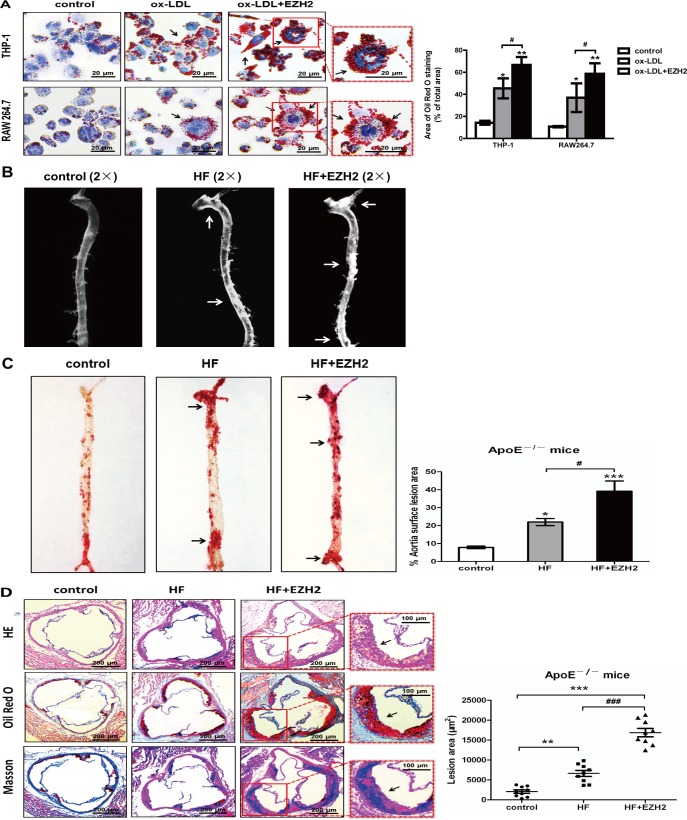
Effects of EZH2 on macrophage cholesterol accumulation and aortic plaque.A, EZH2 enhanced cholesterol accumulation in THP-1 and RAW264.7 macrophage-derived foam cells. THP-1/RAW264.7 macrophages were stained for lipids with Oil red O. The nuclei were stained with hematoxylin. Control: 25 μg/ml human apoA-I alone but infected with LV-mock vector; ox-LDL: 25 μg/ml human apoA-I, 50 μg/ml ox-LDL with LV-mock vector; ox-LDL+EZH2: 25 μg/ml human apoA-I, ox-LDL (50 μg/ml) with LV-EZH2 vector. The arrow indicates foam cells visualized under a light microscope with ×400 magnification, scale bar, 20 μm. Results are representative of 3 independent experiments. Bar graph data is based on Image-Pro Plus software. Mean ± S.D., one-way ANOVA, *: P<0.05 and **: P<0.01 vs. control, #: P<0.05 vs. ox-LDL+EZH2. B, Stereomicrographs showing atherosclerotic plaques of apoE−/− mice (arrows). Control group: apoE−/− mice fed on chow diet and injected with LV-mock; HF group: apoE−/− mice fed on high fat diet and injected with LV-mock; HF+EZH2 group: apoE−/− mice fed on high fat diet and injected with LV-EZH2. C, The plaque formation showed by Sudan IV staining. The area of the lesion in % of the total aortic area, n = 9, mean ± SEM, one-way ANOVA, *: P<0.05 and ***: P<0.001 vs. control, #: P<0.05 vs. HF+EZH2. D, Photomicrographs showing aortic sinus lesions of apoE−/− mice. The atherosclerotic plaque is stained with HE, Oil red O and MT. Scale bar, 200 μm in left panel, 100 μm in right panel. The area of aortic sinus lesion, n = 9, each group. Mean ± SEM, **: P<0.01 and ***: P<0.001 vs. control, ###: P<0.001 vs. HF+EZH2.